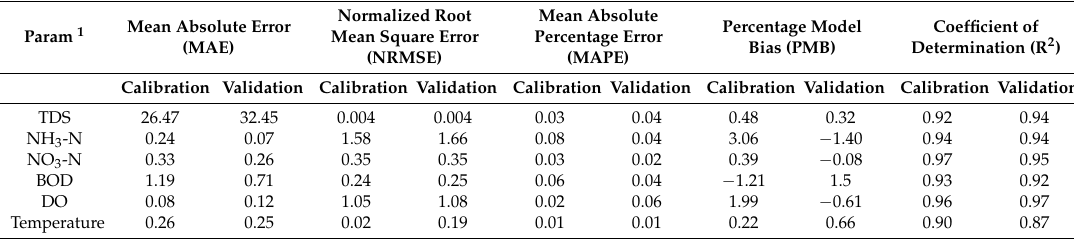
Table 5. Statistical evaluation of calibrated and validated model results.